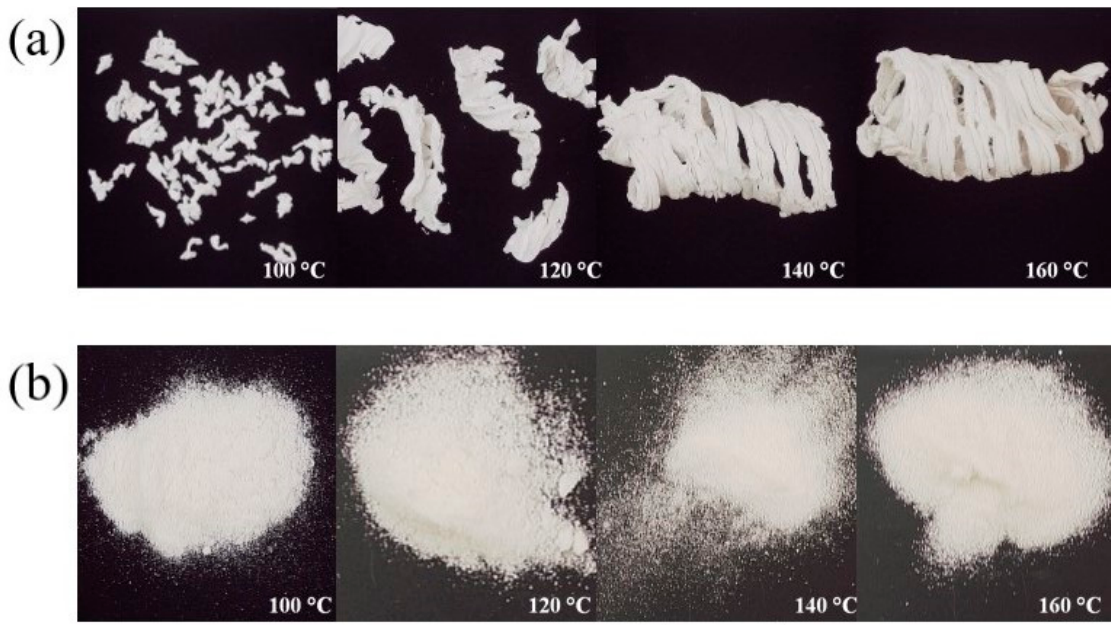
Figure 2. ( a ) Extrudates/agglomerates obtained after extrusion of metformin HCl (75%) and HPC GXF (25%) ( b ) Powdery agglomerates obtained after extrusion of metformin HCl (75%) and HPMC HME 4M (25%) at processing temperatures of 100, 120, 140, and 160 ◦ C. High shear screw configuration SC#1 was used for the process. Agglomerates obtained in the case of HPC GXF were irregular and larger in size at a lower processing temperature of 100 ◦ C. At processing temperatures of 120, 140, and 160 ◦ C, the agglomerates looked like ribbon-shaped extrudates, thereby indicating excellent binding capacity. With HPMC HME 4M, fine granules were obtained at 100, 120, 140 ◦ C. At processing temperature of 160 ◦ C, the granules were slightly larger with considerably lower proportion of fine